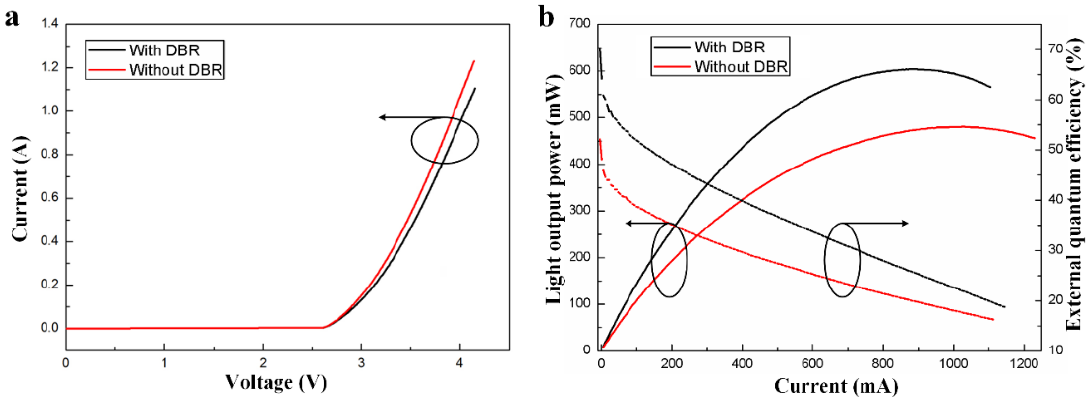
Figure 6. ( a ) Current versus voltage of FCLEDs with and without DBR. ( b ) Light output power versus current and EQE versus current characteristics of FCLEDs with DBR and without DBR.